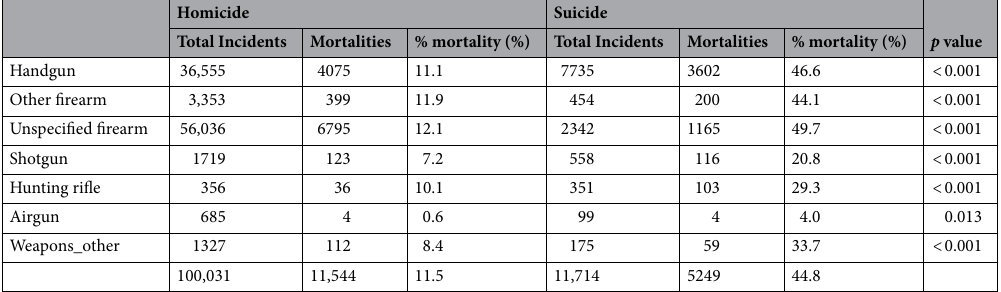
Table 5. Groups differ in the involvement of weapon types and resulting mortality by group. The number of incidents resulting in mortality and the percent within the group and weapon type, are reported. p Values are from Fisher’s exact tests to test differences in mortality between groups for each weapon